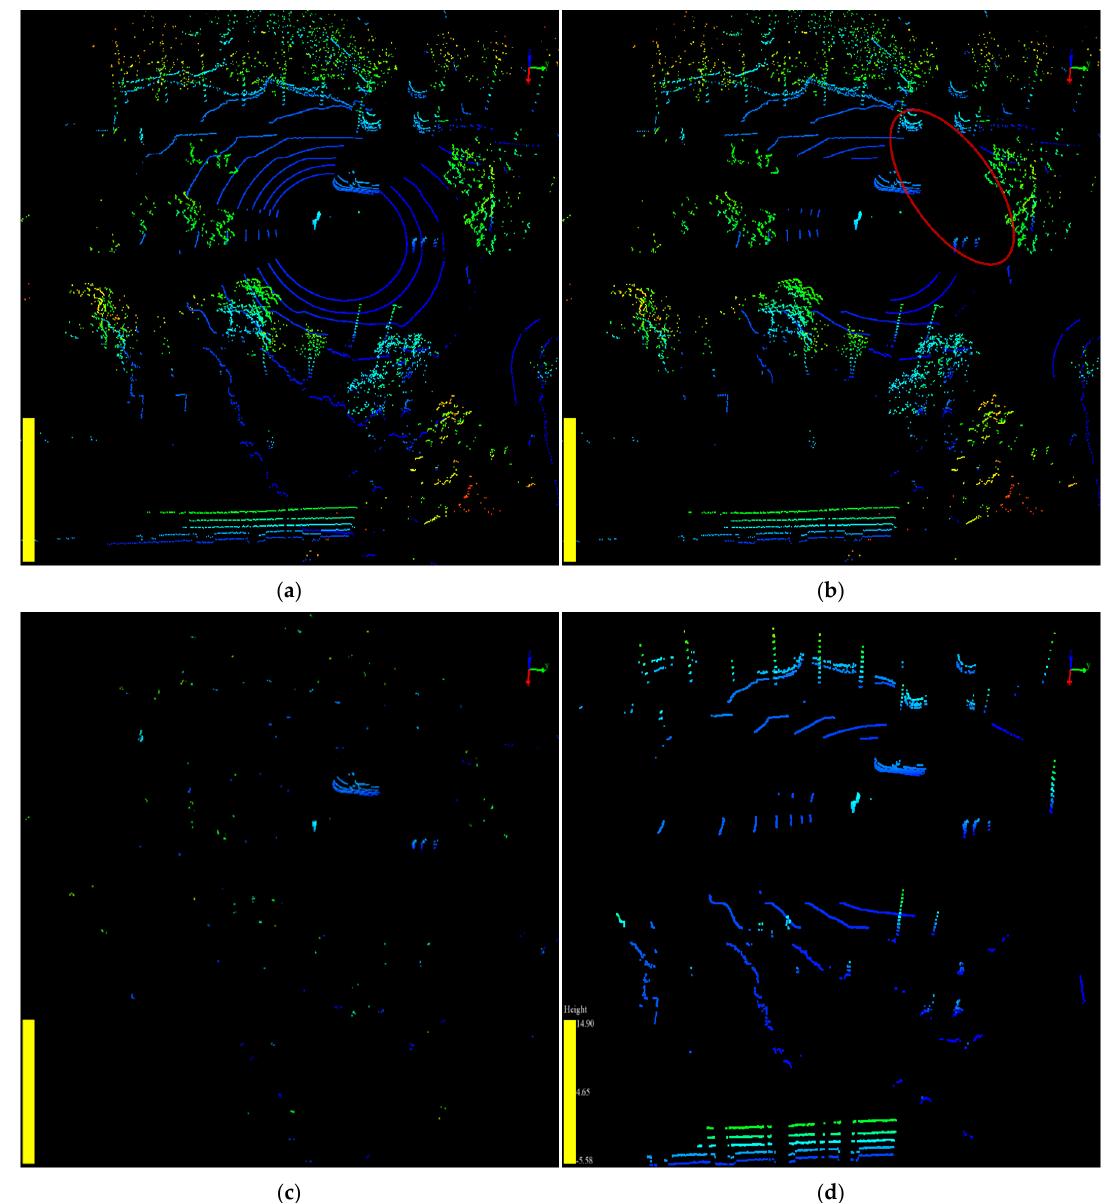
Figure 16. The point cloud before and after background point filtering by different algorithms are shown in VeloView. ( a ) The raw point cloud before background point filtering. ( b )The point cloud after being filtered by random sample consensus algorithm (RANSAC); ( c ) The point cloud after being filtered by 3-D-DSF; ( d ) The point cloud after being filtered by slice-based projection filtering algorithm (SPF).